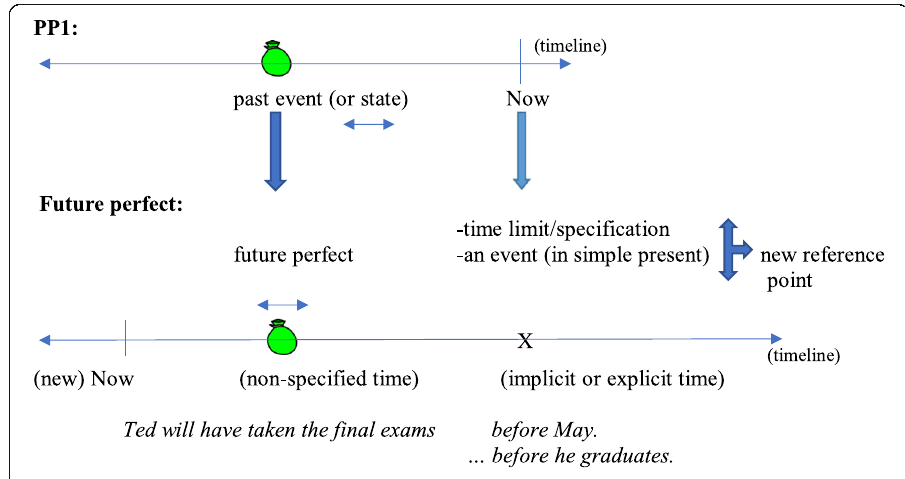
Fig. 8 The temporal characteristics of future perfect, derived from PP1 (perfect